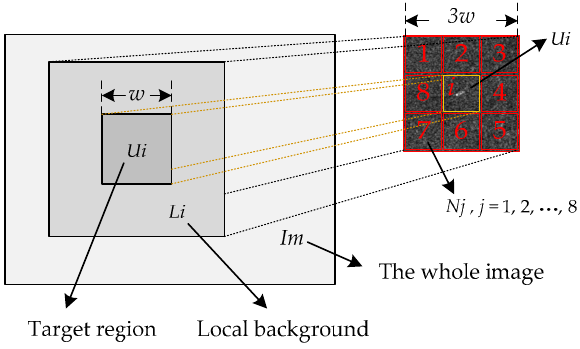
Figure 2. Local region and local background window.